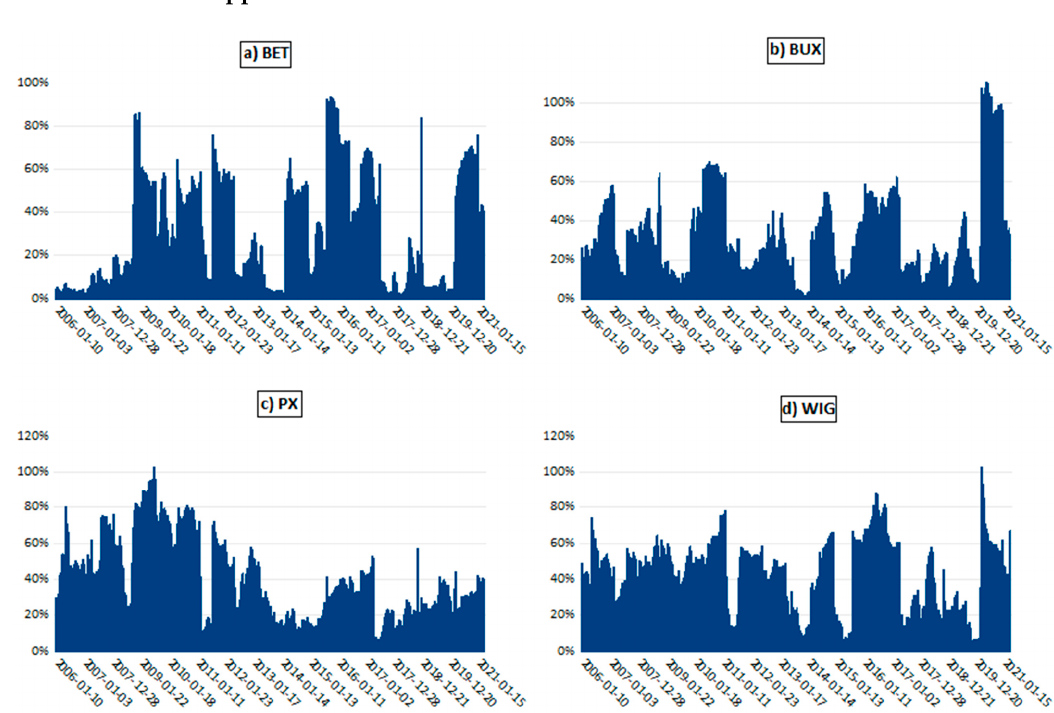
Figure A7. Directional Volatility Spillovers Transmitted by Each Stock Market Index to All the Other Three Indices.